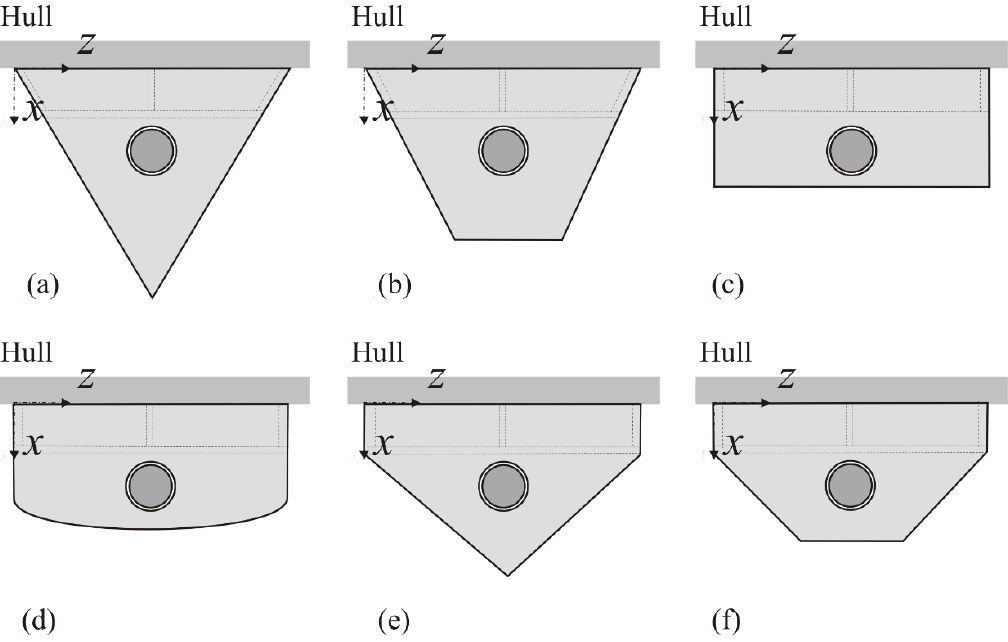
Figure 7. Representation of the different configurations of brackets studied here: ( a ) triangular, ( b ) trapezoidal, ( c ) rectangular, ( d ) rectangular/elliptical, ( e ) rectangular/triangular, ( f ) rectangular/trapezoidal.